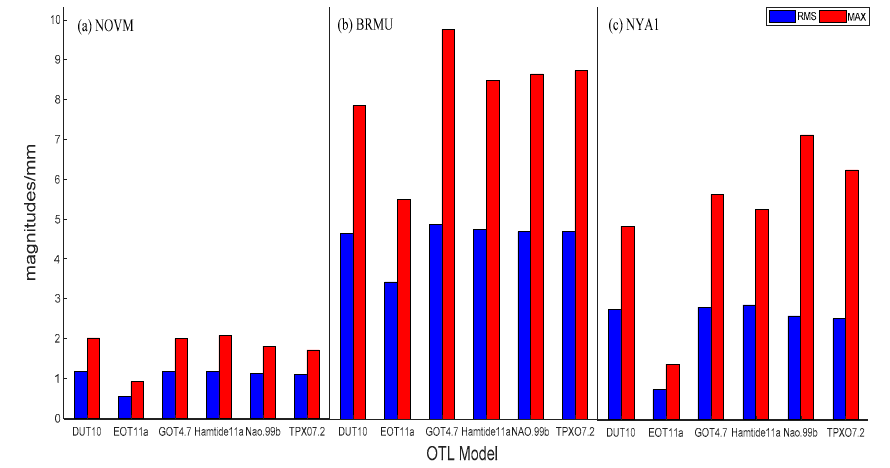
Figure 7. The root-mean-square (RMS) value and maximum value of the differences between the vertical OTL displacement from the FES2004 model (as reference) and other OTL models at the ( a ) NOVM station, ( b ) BRMU station, and ( c ) NYA1 station.